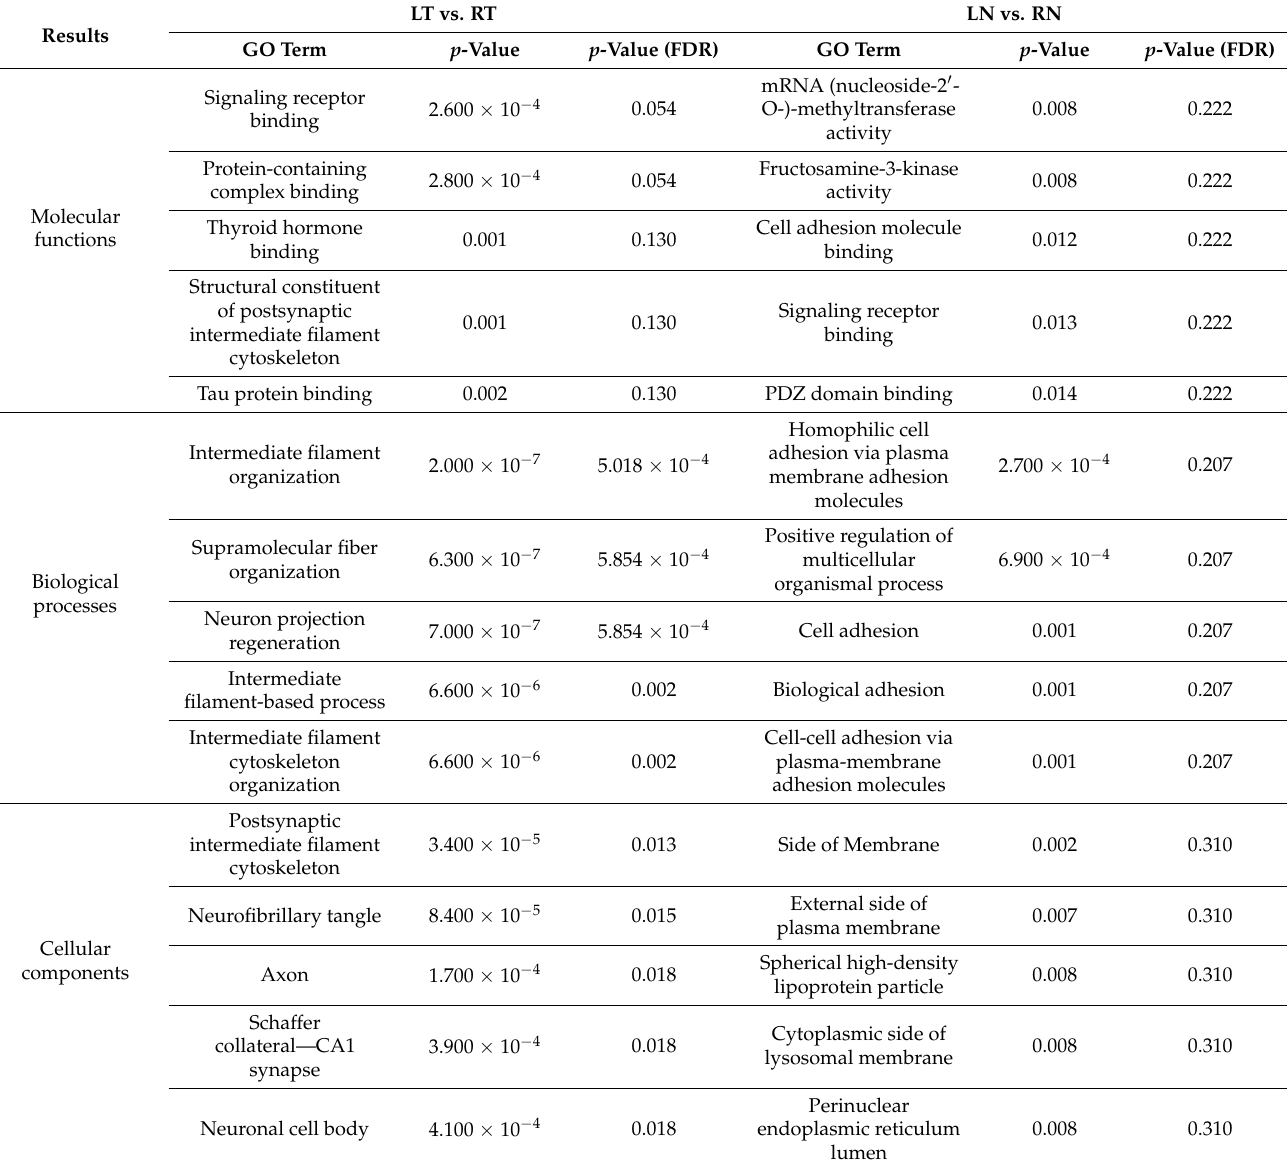
Table 6. Gene ontology analysis of temporal and nasal quadrants 2 weeks after